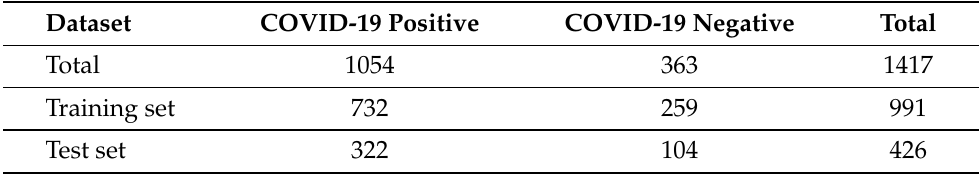
Table 3. Dataset count for training and testing data used in the